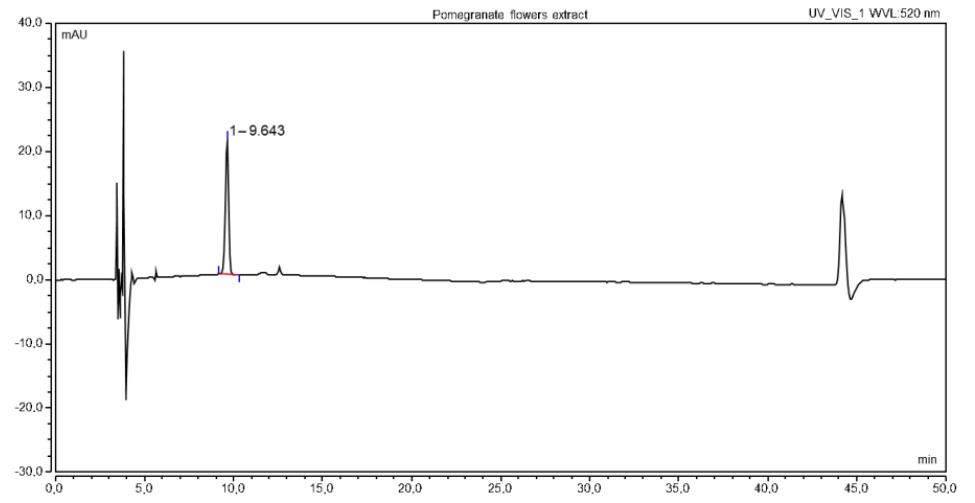
Figure 5. The chromatogram of pomegranate flowers extract.